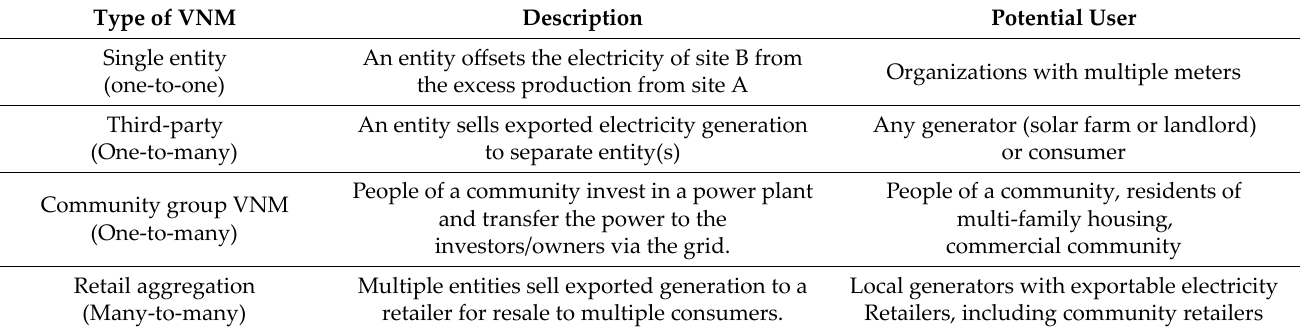
Table 1. Typologies of VNM, description, and potential users. Adapted from [20]. Type of VNM Description Potential